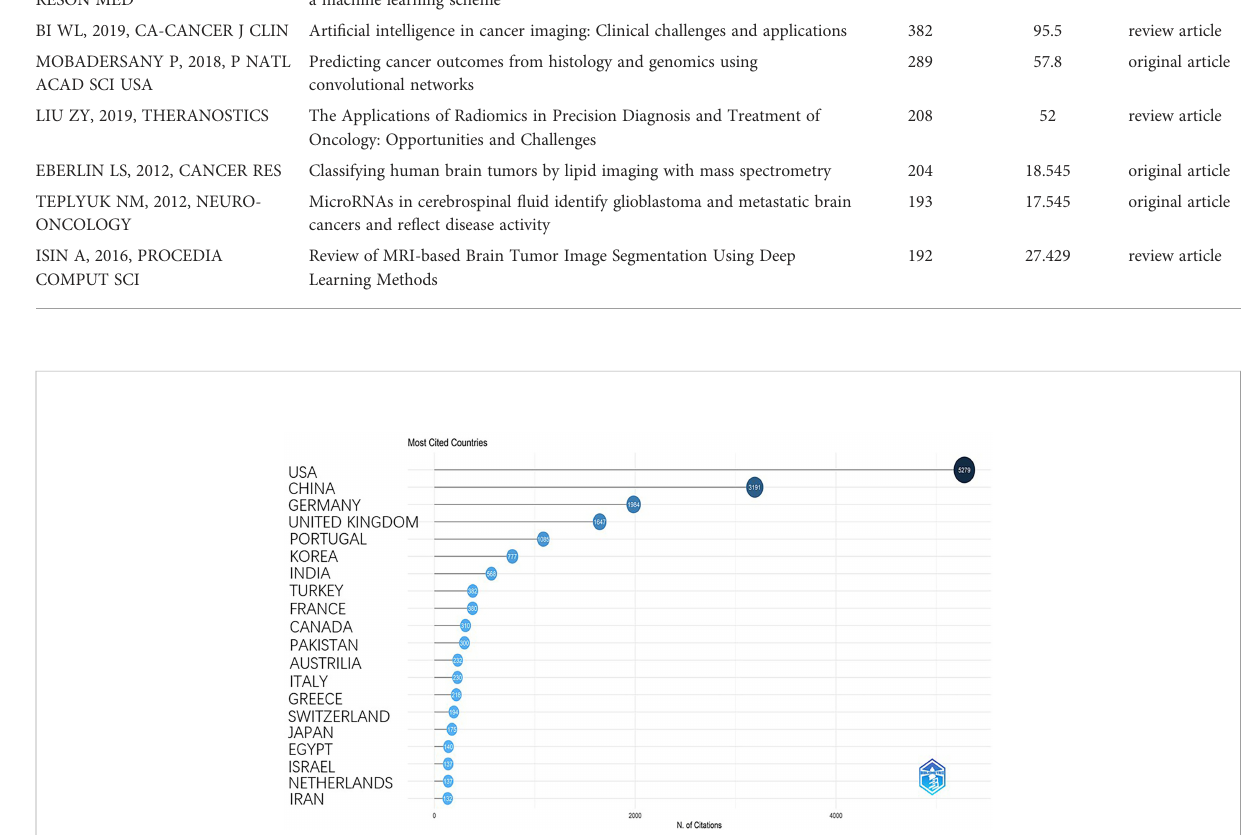
FIGURE 10 It represents the rank of cited publications of different